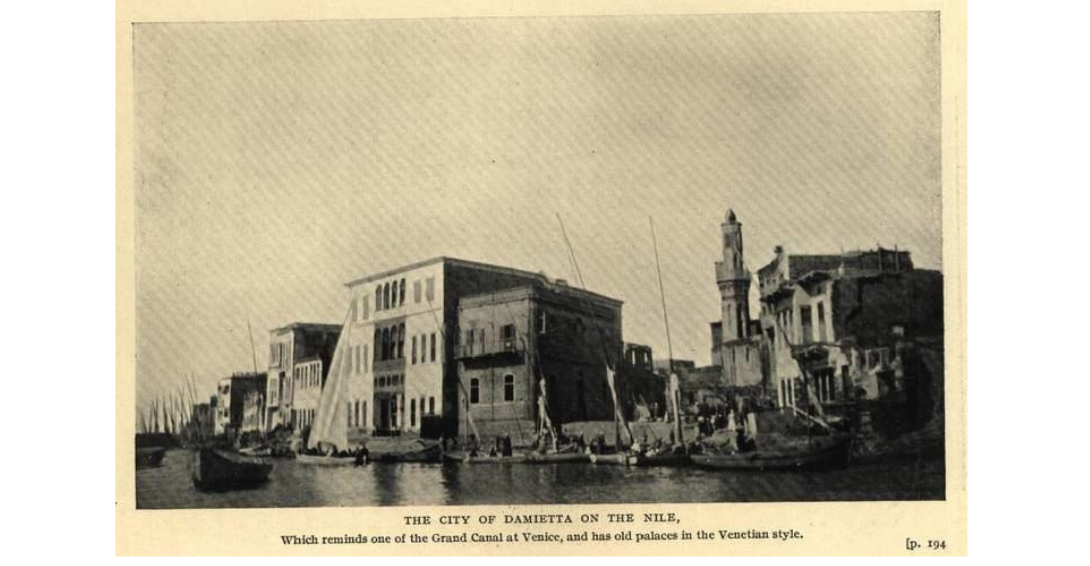
Figure 1. The city of Damietta on the Nile (Source: Douglas Sladen, ‘The City of Damietta on the Nile’ (1911), Rice University,